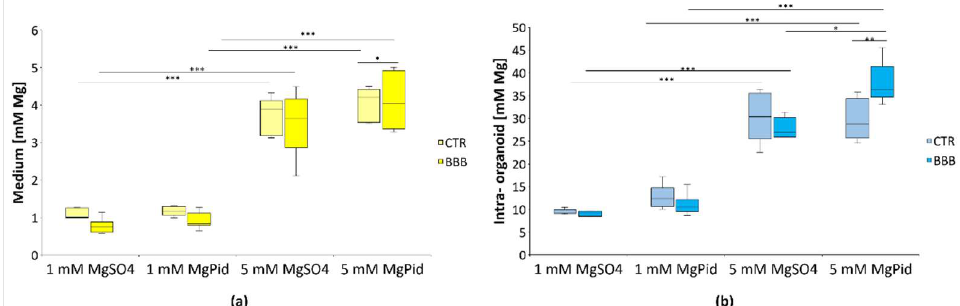
Figure 4. Magnesium concentration in the lower chamber and in the brain organoids in the presence or absence of the BBB: ( a ) Human brain organoids were cultured with (BBB) or without (CTR) the BBB and treated with the Mg salts for 4 days. The culture medium of the lower chamber was collected and Mg concentration was measured; ( b ) The organoids were lysed through repeated freeze–thawing cycles and 30 µg of each sample was used to measure Mg concentration. Box plot shows the quantification of at least three independent experiments in triplicates. Each box represents the interquartile range (25th to 75th percentiles), the horizontal line inside is the median value, and the whiskers represent the range. Two-way ANOVA was performed. * p ≤ 0.05, ** p ≤ 0.01, *** p ≤ 0.001.